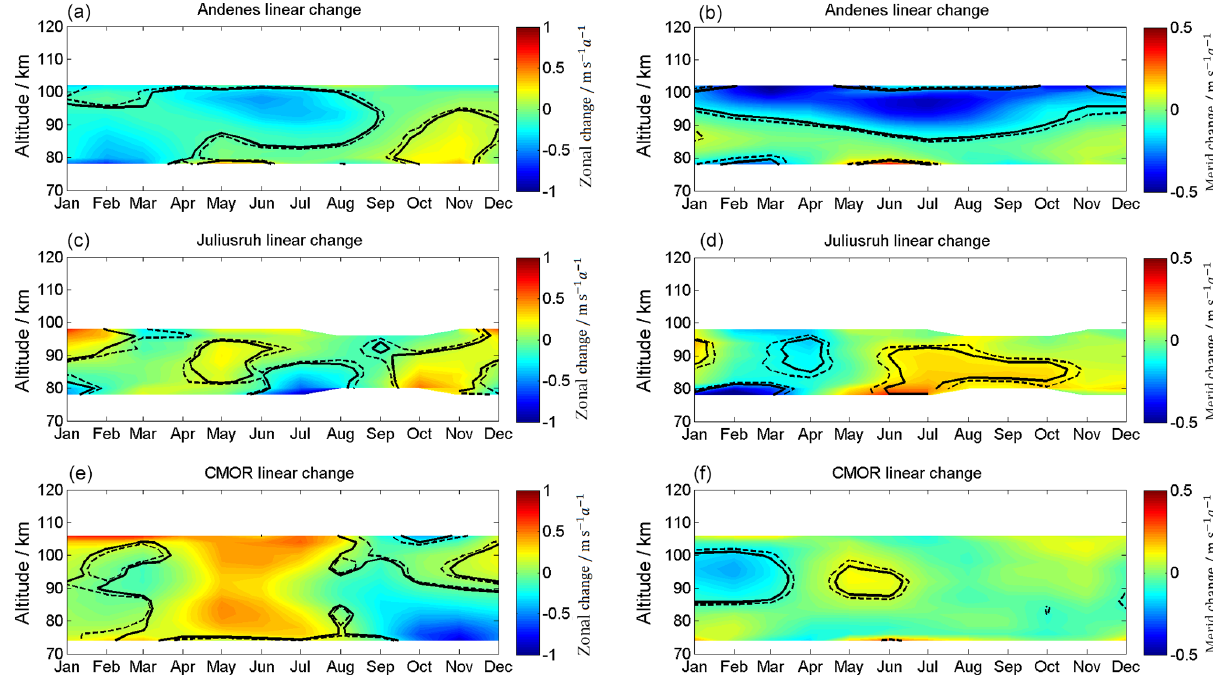
Figure 5. Linear long-term changes in zonal (a, c, e) and meridional (b, d, f) wind for Andenes (a, b) , Juliusruh (c, d) , and CMOR (e, f) . Note the different labels of the color bar. The solid black lines correspond to the 95% significance, the dashed black lines to the 90%